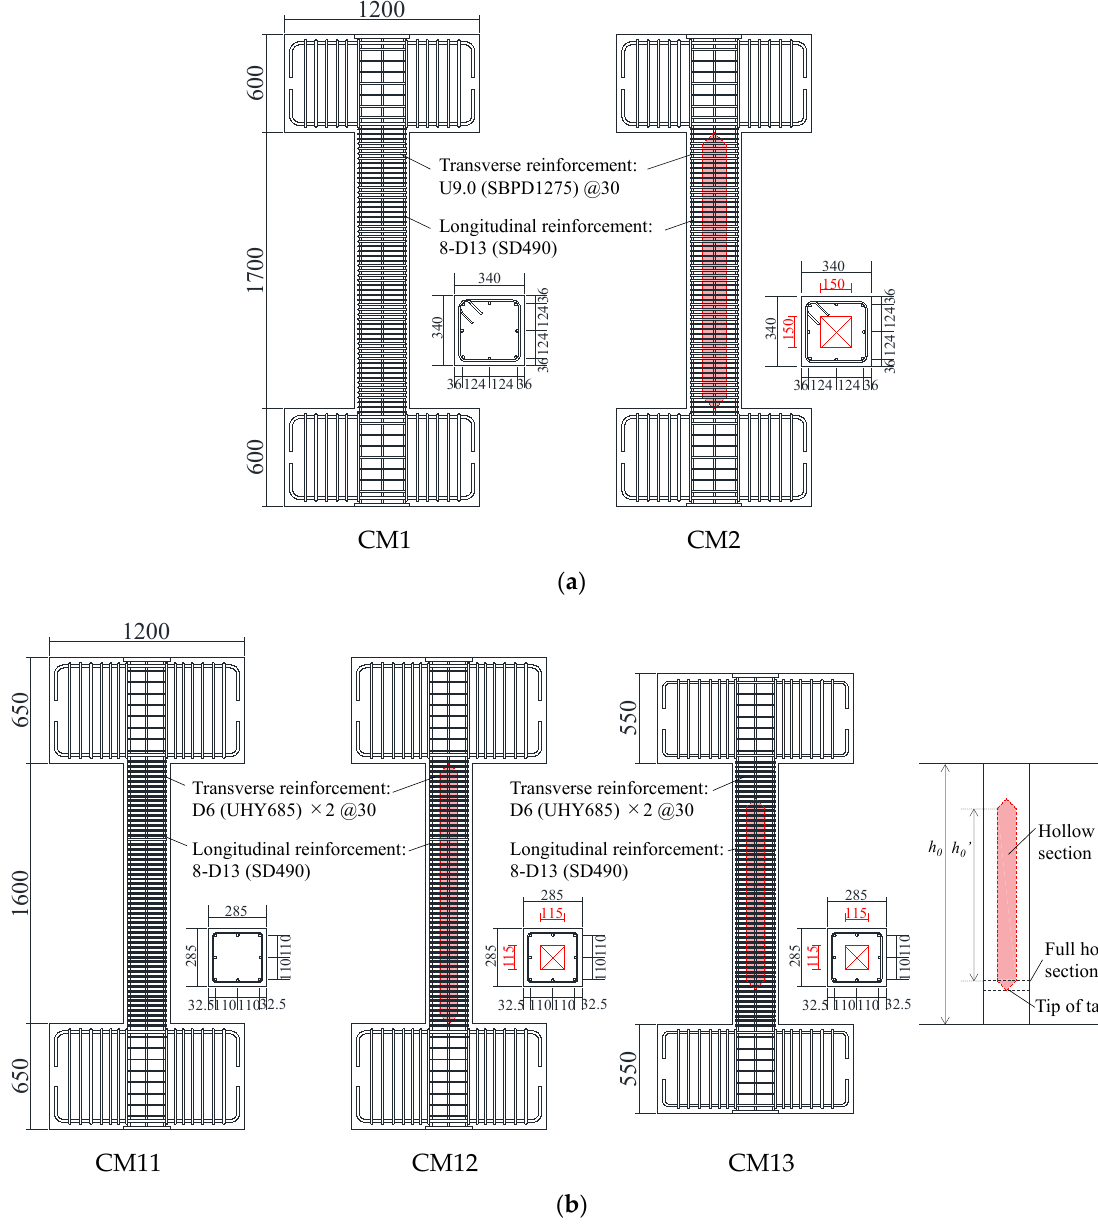
Figure 1. Specimen details: ( a ) N-series; ( b ) S-series.